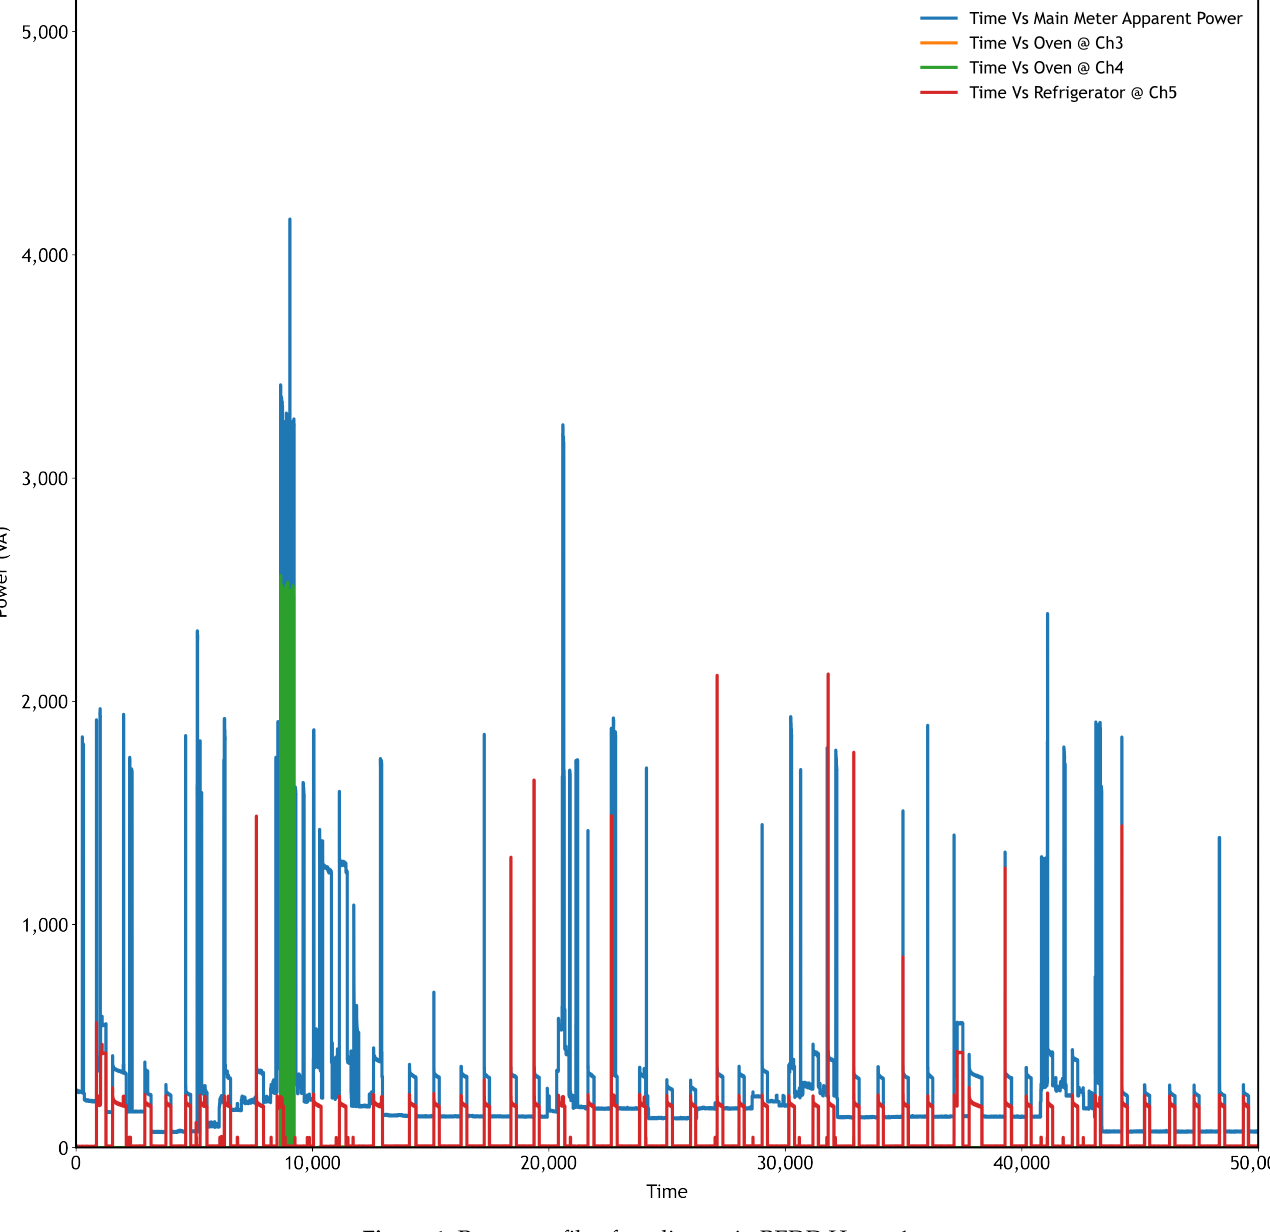
Figure 1. Power profile of appliances in REDD House